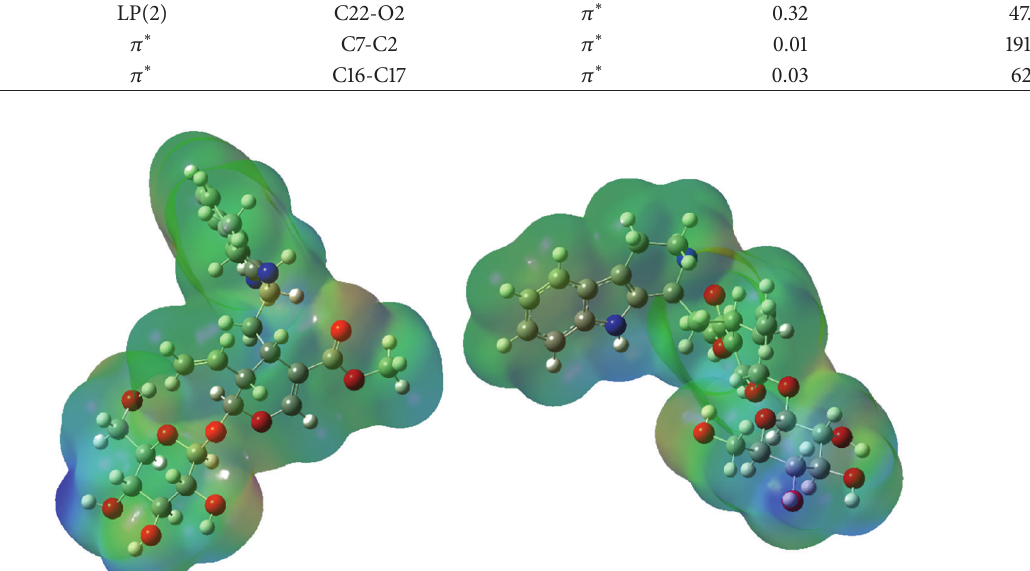
Figure 6: Molecular electrostatic potential maps (from two perspectives) for strictosidine calculated using the B3LYP/6-31G(d) basis set.